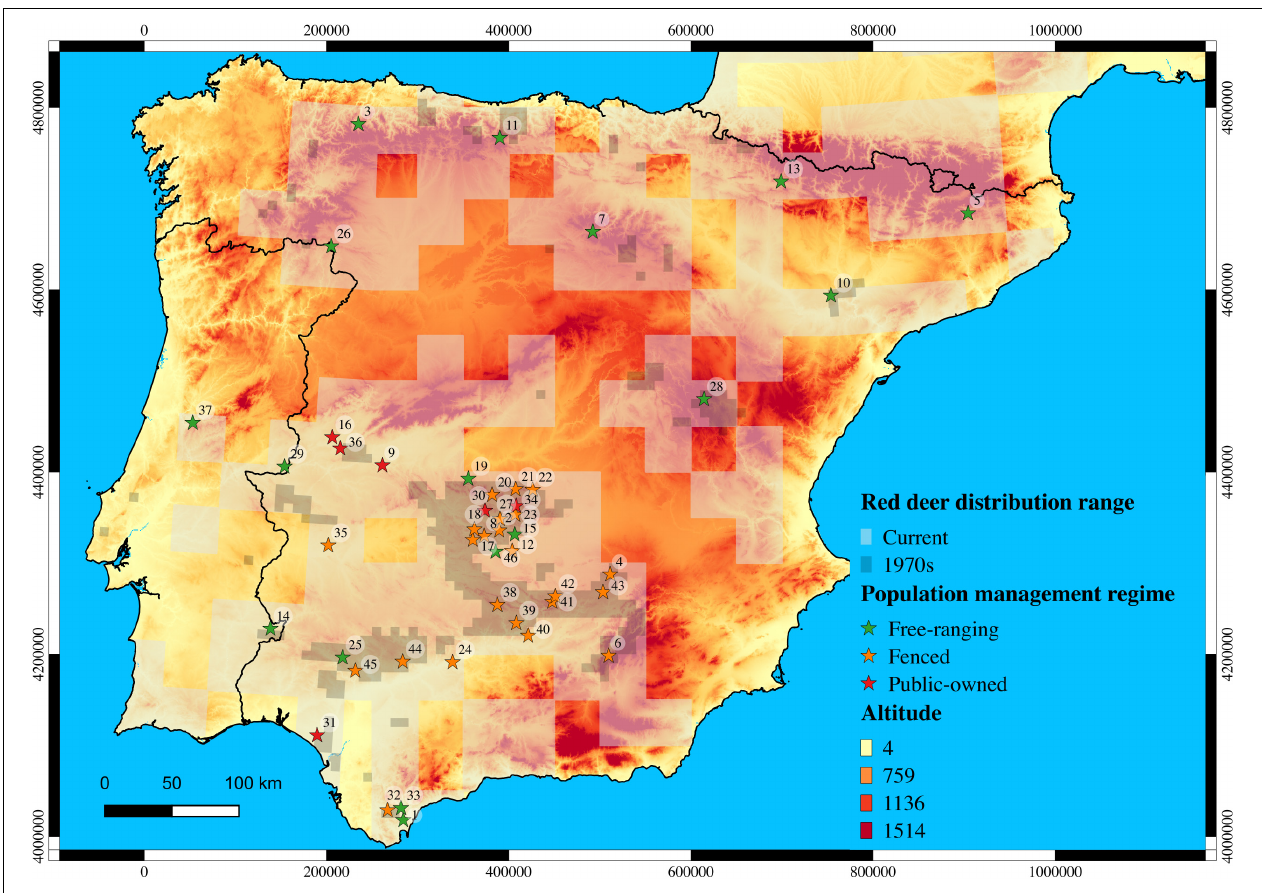
FIGURE 1 | Red deer populations sampled throughout the Iberian Peninsula under the hunting management regime. Current and past (1970s) distribution range of species is depicted in light and dark gray, respectively (Ministerio de Agricultura, 1968; Mitchell-Jones et al., 1999; Salazar, 2009). Population codes are represented within